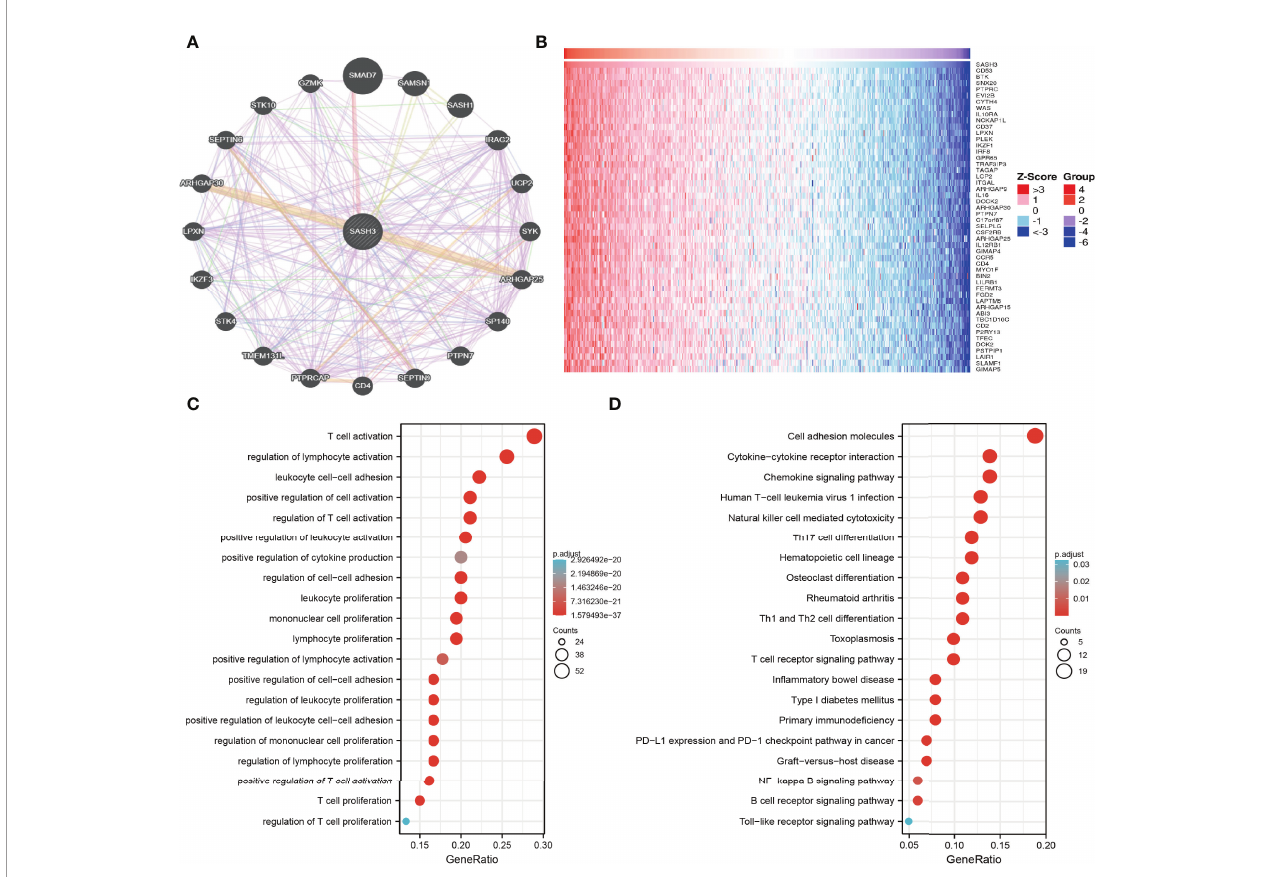
FIGURE 7 | KEGG enrichment analysis. (A) The gene – gene interaction network of SASH3 examined by the GeneMANIA database. (B) The heatmap of the top 50 genes positively correlated with P4HA1 expression. (C) GO analysis of the biological process of SASH3 in pan-cancer. (D) KEGG pathway study revealed that these genes were involved in the different signaling